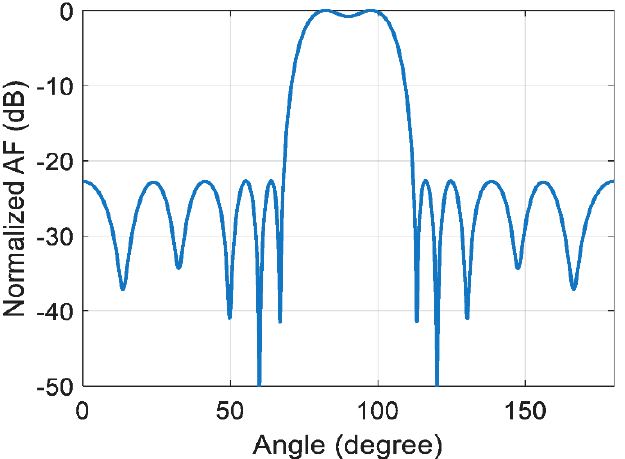
Figure 7. The normalized array factor for 20 element array antenna by modifying the inter-element spacing of the array antenna using